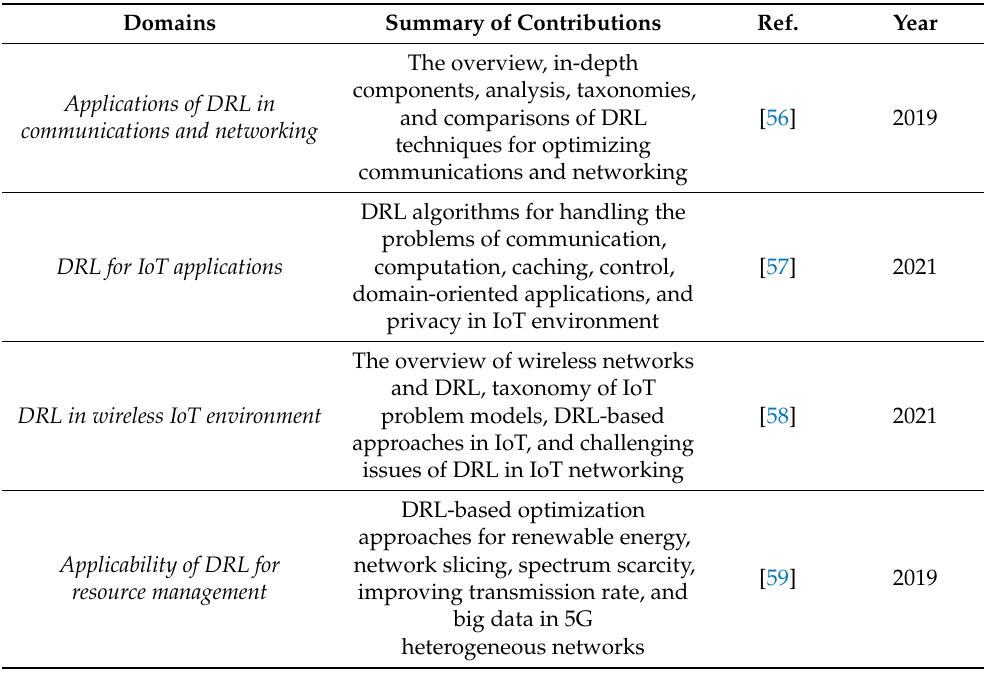
Table 3. Contributions of Existing Selected Surveys on Deep Reinforcement Learning. Domains Summary of Contributions